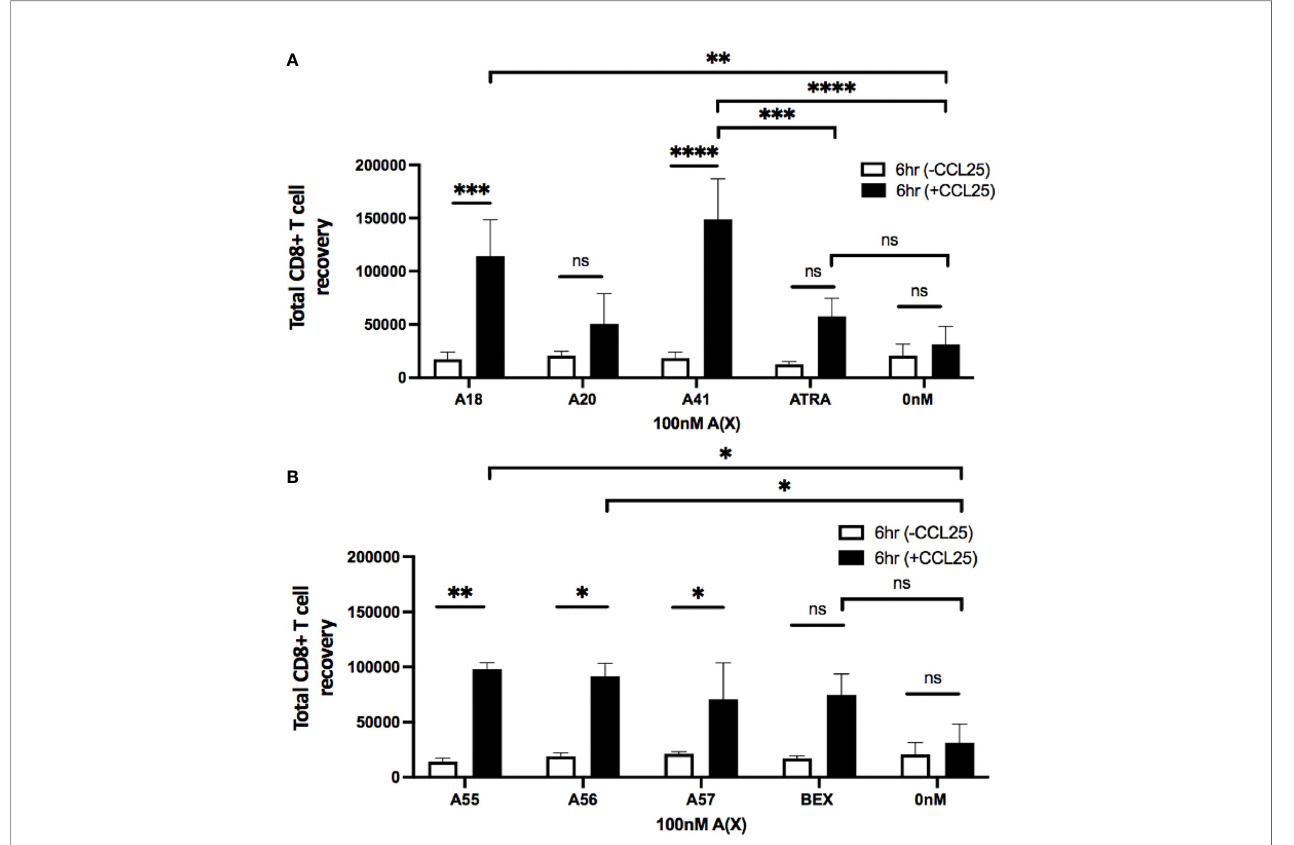
FIGURE 5 | Treatment with ATRA independent andATRA cooperating rexinoids enhances effectorCD8+ T cell migration towards the mucosally expressedchemokine CCL25 invitro . Splenocytes obtainedfrom P14 mice were stimulatedwith GP 33-41 peptide and cultured for 7 dayswith 100nM selected rexinoidsor 10nM ATRA. Cellswere then subjectedto a Boyden chamber assay.5x10 5 splenocytes resuspended in chemotaxisbuffer were seeded into the top insert ofa 96 wellHTS Transwell plate and allowed 6 hours to migrate through a membrane (3.0um pore size) towards CCL25 (250nM concentration) platedin the lower chamber.Cellswere then isolated fromthe bottomchamber and manually counted using a hemocytometer. (A) Migration followingcell culture with ATRA independent rexinoids orATRA. T cell migration towards CCL25 was signi fi cantly improved when cells were cultured with A18 and A41 (adjusted p values = 0.0009 and < 0.0001, respectively). Treatmentwith A18 or A41 also signi fi cantly improved migration towardsCCL25 compared to notreatment given (adjustedp values = 0.004 and 0.0001, respectively).Treatment with A41 also signi fi cantly improved migration compared to treatment with ATRA (adjusted p value = 0.0008).AllATRA independent rexinoidsandATRA tested intriplicate. (B) Migration followingcell culture with ATRA cooperating rexinoidsor BEX. Migration towards CCL25 was signi fi cantly improved when cells were cultured with A55, A56, and A57 (adjustedp values = 0.001, 0.01, and 0.02, respectively). Treatment with A55 or A56 signi fi cantly improvedmigration towards CCL25 compared to notreatmentgiven (adjusted p values = 0.01 and0.02, respectively).A55, A56, and BEX rexinoidstested in duplicate, A57 rexinoid testedin triplicate. Statistics were calculatedusing a two-way ANOVA (*= p < 0.05, ** = p < 0.005, *** = p < 0.0005, **** = p < 0.0001). Allerror barsrepresent SDfromthe mean.ns, not signi fi cant.